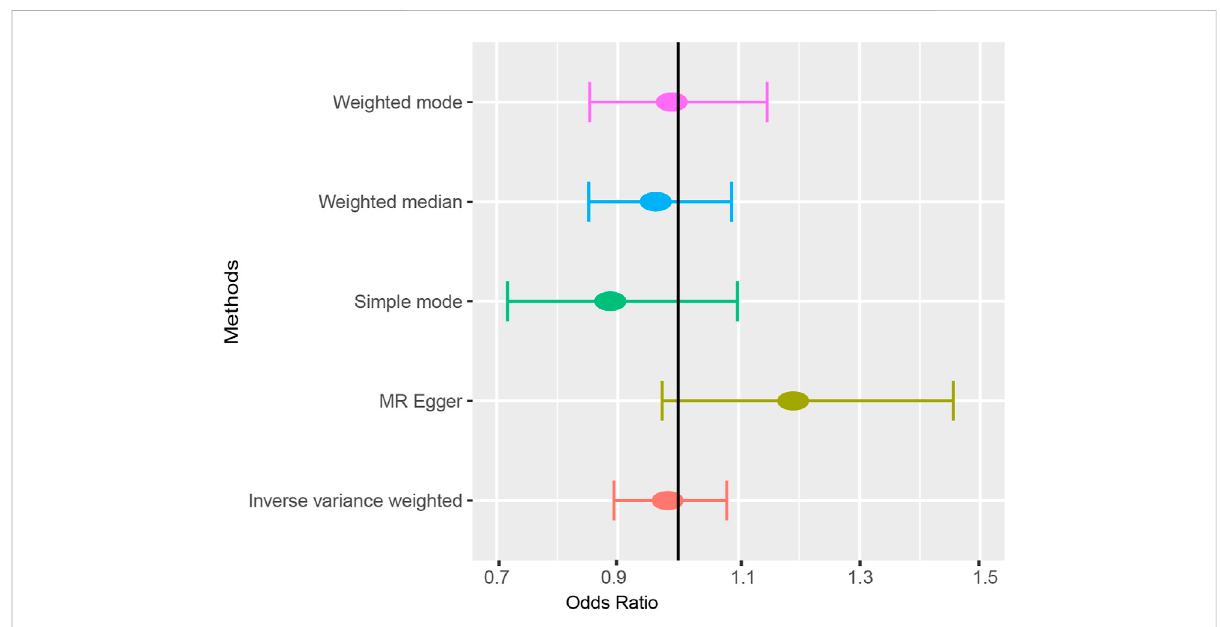
FIGURE 3 The forest plot of fi ve Mendelian randomization